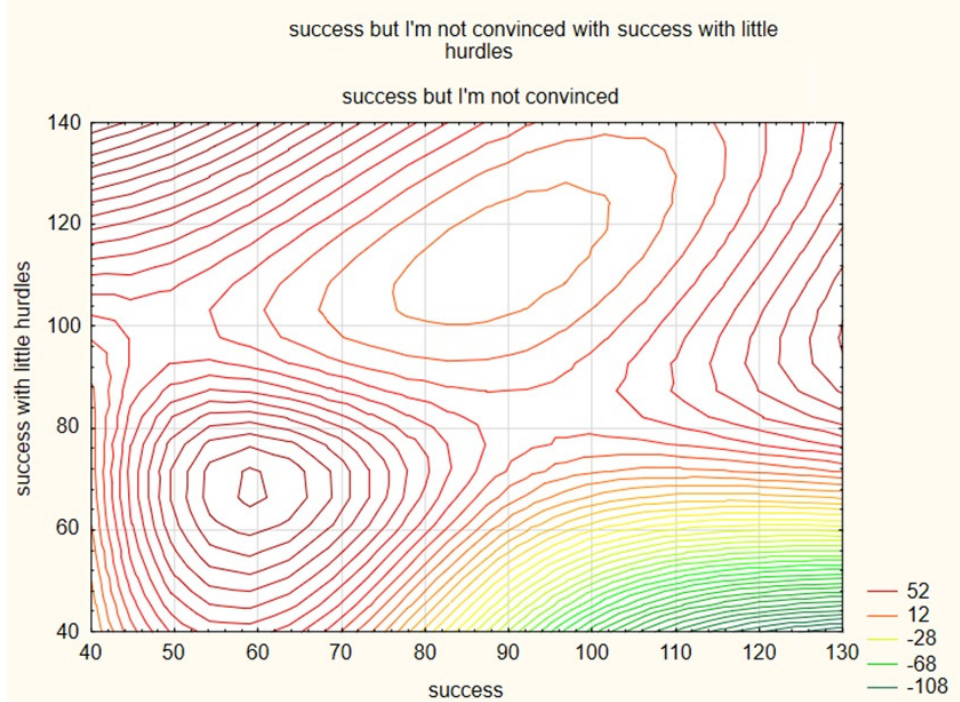
Figure 27. A layered approach to success.